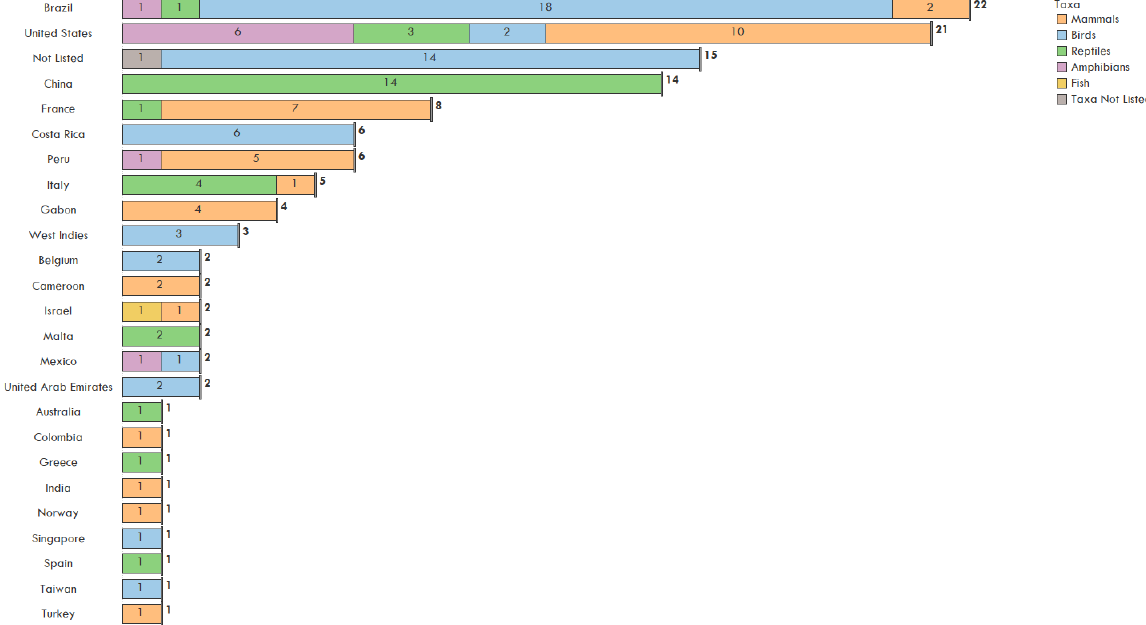
Figure 6. Number of pathogens including viral, bacterial, fungal, protozoan, endoparasites, and ectoparasites introduced through the illegal wildlife trade by country of import, 1990–2020. 4. Discussion We know emerging infectious diseases (EIDs) tend to be more prevalent in regions with higher human population density, higher land use for agricultural purposes, inten- sive livestock and poultry production, and perhaps larger biodiversity (specifically more mammal species). Additionally, EIDs appear more common in tropical regions with high levels of biodiversity (hotspots), vast tropical forests and significant habitat destruction [110].